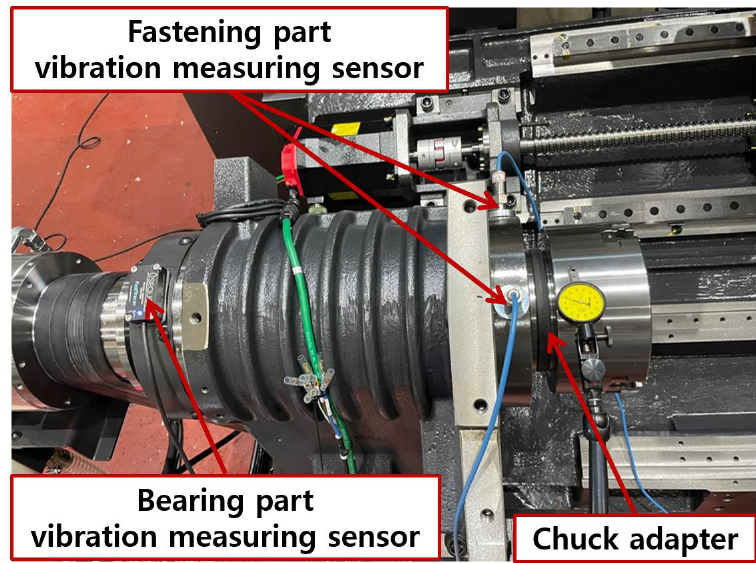
Figure 6. Experimental setup for vibration experiment.